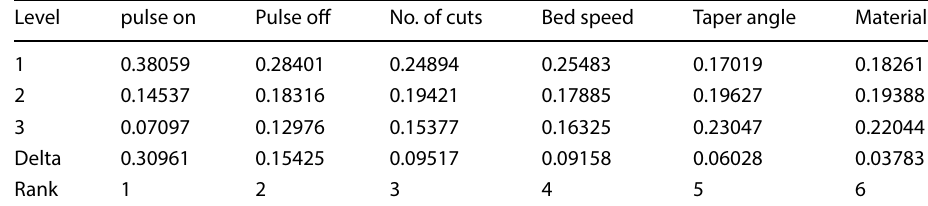
Table 12 Response table for means ( ERR )